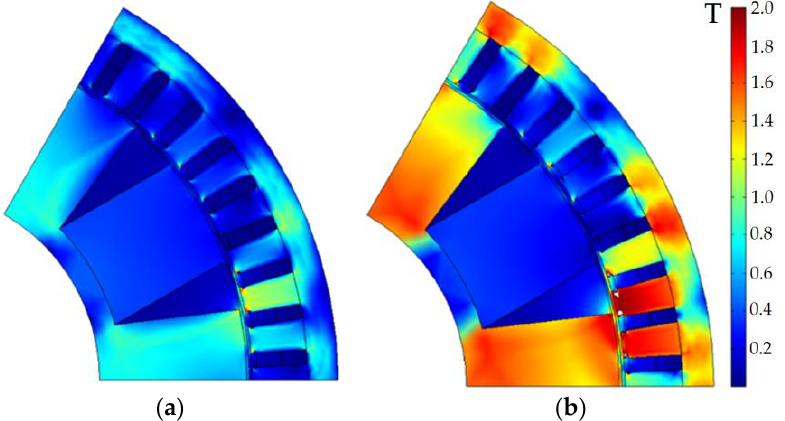
Figure 11. The torque ripple of the individual SRSC and the symmetrized (output) torque ripple after optimization: ( a ) at 3450 rpm; ( b ) at 750 rpm.